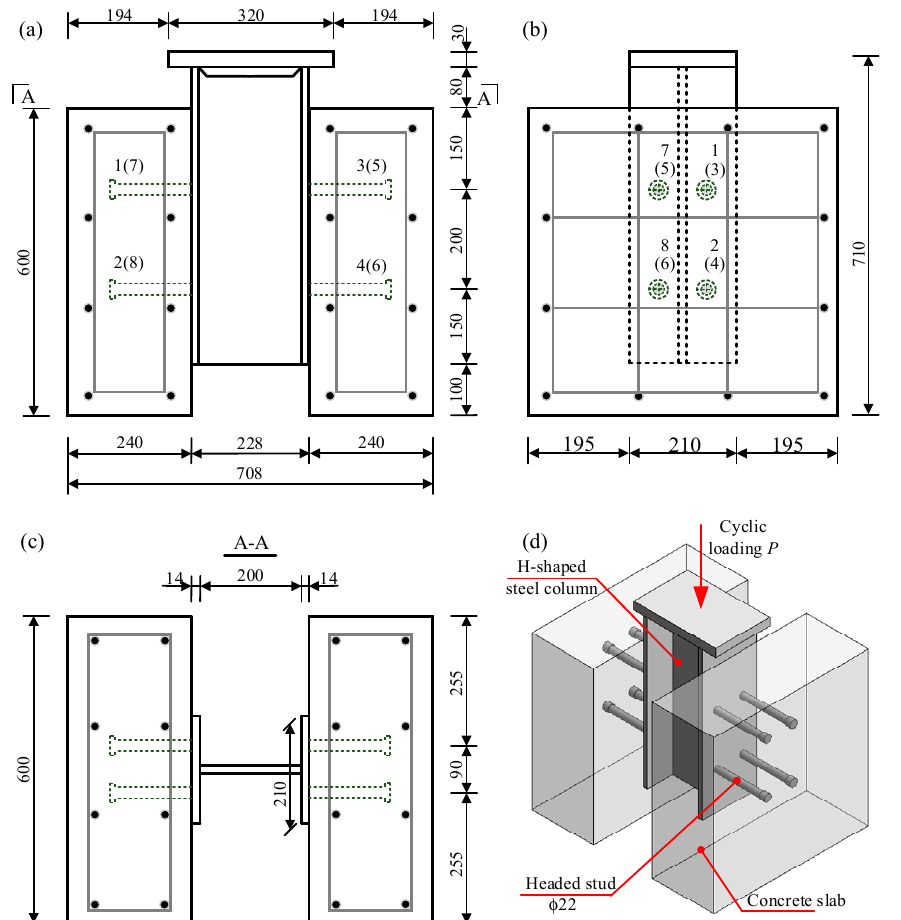
Figure 2. Geometric details of push-out specimens (unit: mm): ( a ) front view; ( b ) side view; ( c ) A–A view; ( d ) 3D drawing of specimens.